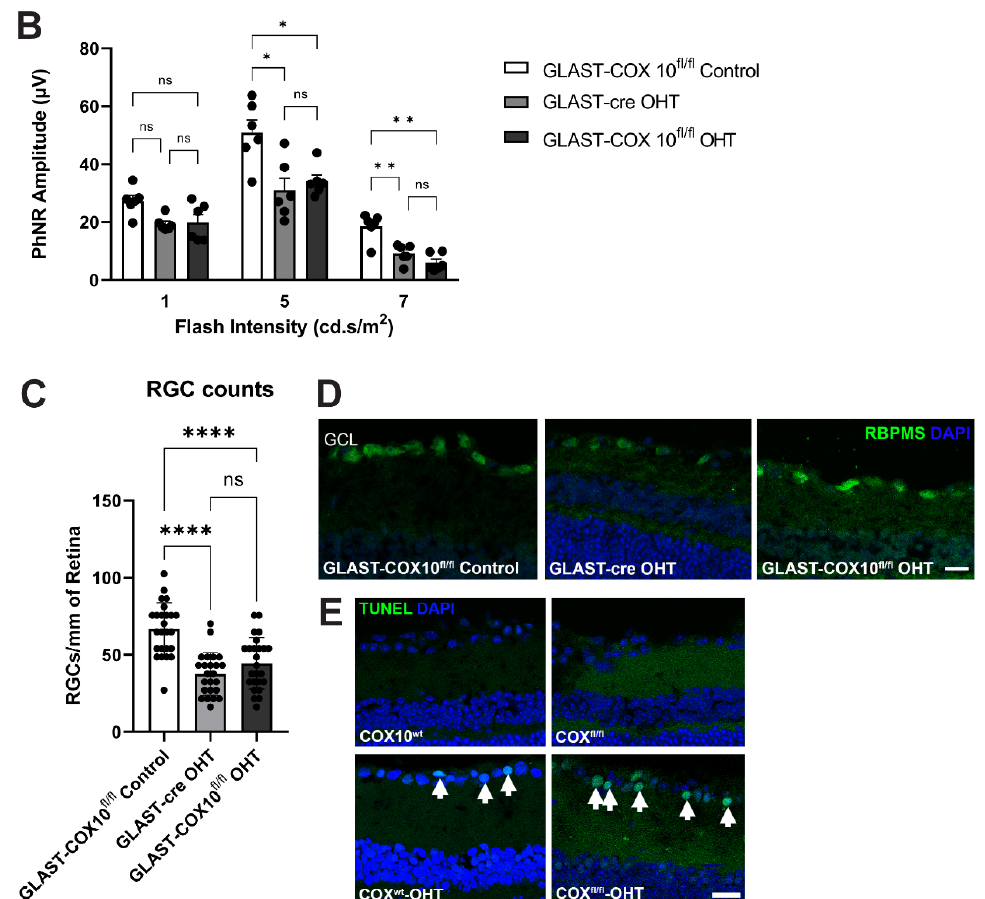
Figure 5. Effect of IOP elevation on photopic negative response in wildtype and GLAST-COX10 fl/fl mice. ( A ) Intraocular pressure was significantly higher in ocular hypertension (OHT) groups (GLAST-COX10 wt and GLAST-COX10 fl/fl ) than in GLAST-COX10 fl/fl control from 7d through 28d. Error bars represent mean ± SEM. ( B ) Photopic negative response (PhNR) mean amplitudes recorded from GLAST-COX10 fl/fl mice with and without OHT, plus wildtype (GLAST-cre) mice with OHT under light-adapted conditions showed no differences among groups at 1cd.s/m 2 . At 5cd.s/m 2 , both OHT groups had significantly lower PhNR than the knockout without OHT (* p < 0.05). A further reduction of PhNR amplitude was observed at 7cd.s/m 2 , with both OHT groups having significantly reduced PhNR as compared to the GLAST-COX10 fl/fl mice without OHT (** p < 0.01). Values are ± SEM; 6–8 mice per group. * p < 0.05, ** p < 0.01. ( C ) RGC quantification from retinal cross-sections show significantly higher RGC number in GLAST-COX10 fl/fl control retina as compared to both GLAST-cre with OHT (**** p < 0.0001) and GLAST-COX10 fl/fl with OHT (**** p < 0.0001). Error bars represent mean ± SEM. ( D ) Representative immunofluorescence images of retinas from each experimental group that were used for RGC quantification in ( C ). RBPMS (green) was used as an RGC marker. ( E ) TUNEL labeling to identify apoptotic cells (white arrows) in retina showed apoptotic cells in the COX10 wt and COX10 fl/fl groups with OHT only. Scale bars = 25 µ